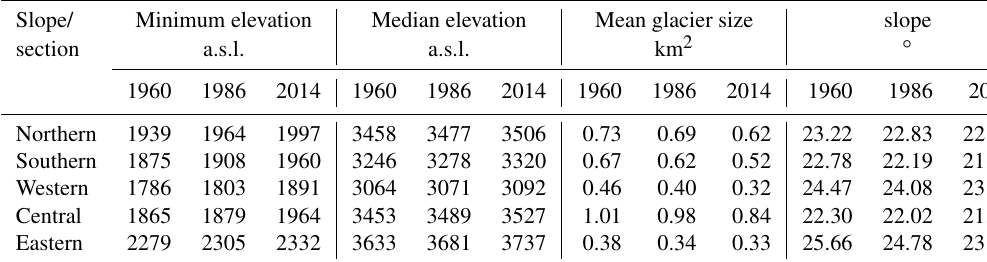
Table 3. Topographic parameters for glaciers in 1960, 1986 and 2014. Slope/